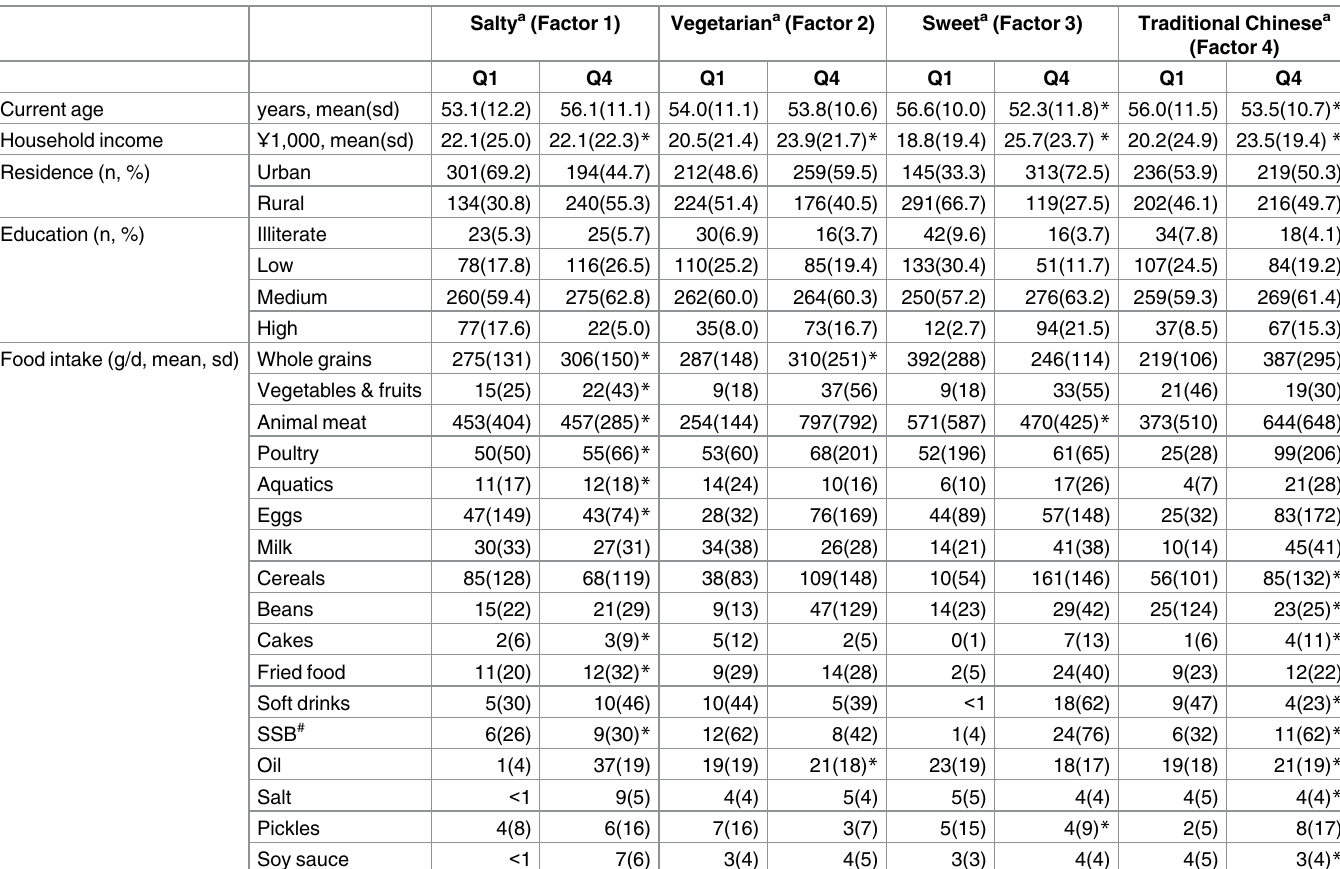
Table 3. Sample characteristics for the lowest (Q1) and highest (Q4) quartiles of four dietary patterns (N =